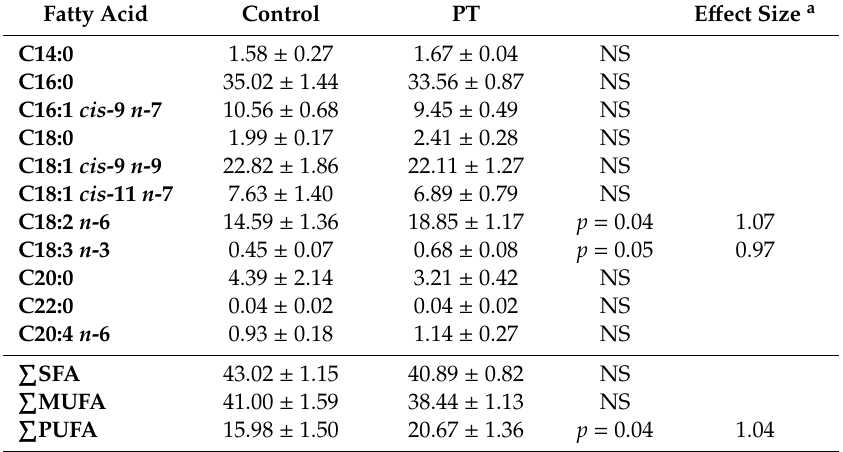
Table 3. Fatty acid profile (% of total hepatic triacylglycerols) of the hepatic triacylglycerols from obese Zucker rats treated or not with pterostilbene (30 mg/kg body weight/day for six weeks).